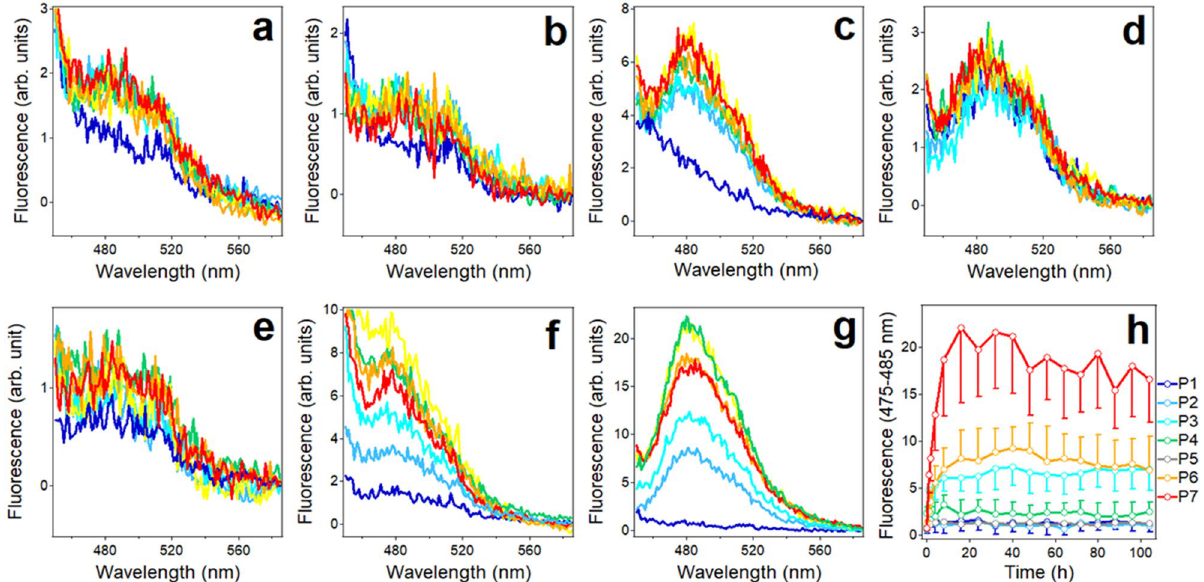
Figure 5. ThT fluorescence spectra of P1, P2, P3, P4, P5, P6, and P7 (panels a through g, respectively) with excitation at 435 nm, at 25 °C. Time of incubation of peptide samples in buffer (25 mM NaCl, 25 mM Na,K- phosphate, pH 7.2) at 70 μM concentration with constant stirring by a tube rotator is as follows: 0.1 h (dark blue), 2.0 h (light blue), 4.0 h (turquoise), 16.0 h (green), 40.0 h (yellow), 64.0 h (orange), 104.0 h (red). Panel h shows the time dependence of ThT fluorescence averaged between 475 and 485 nm for all seven peptides. Average data from three independent experiments. Error bars are shown only for P1, P3, P4, P6, P7 to maintain clarity. Error bars for P2 and P5 are of similar magnitude as for those of P1 and